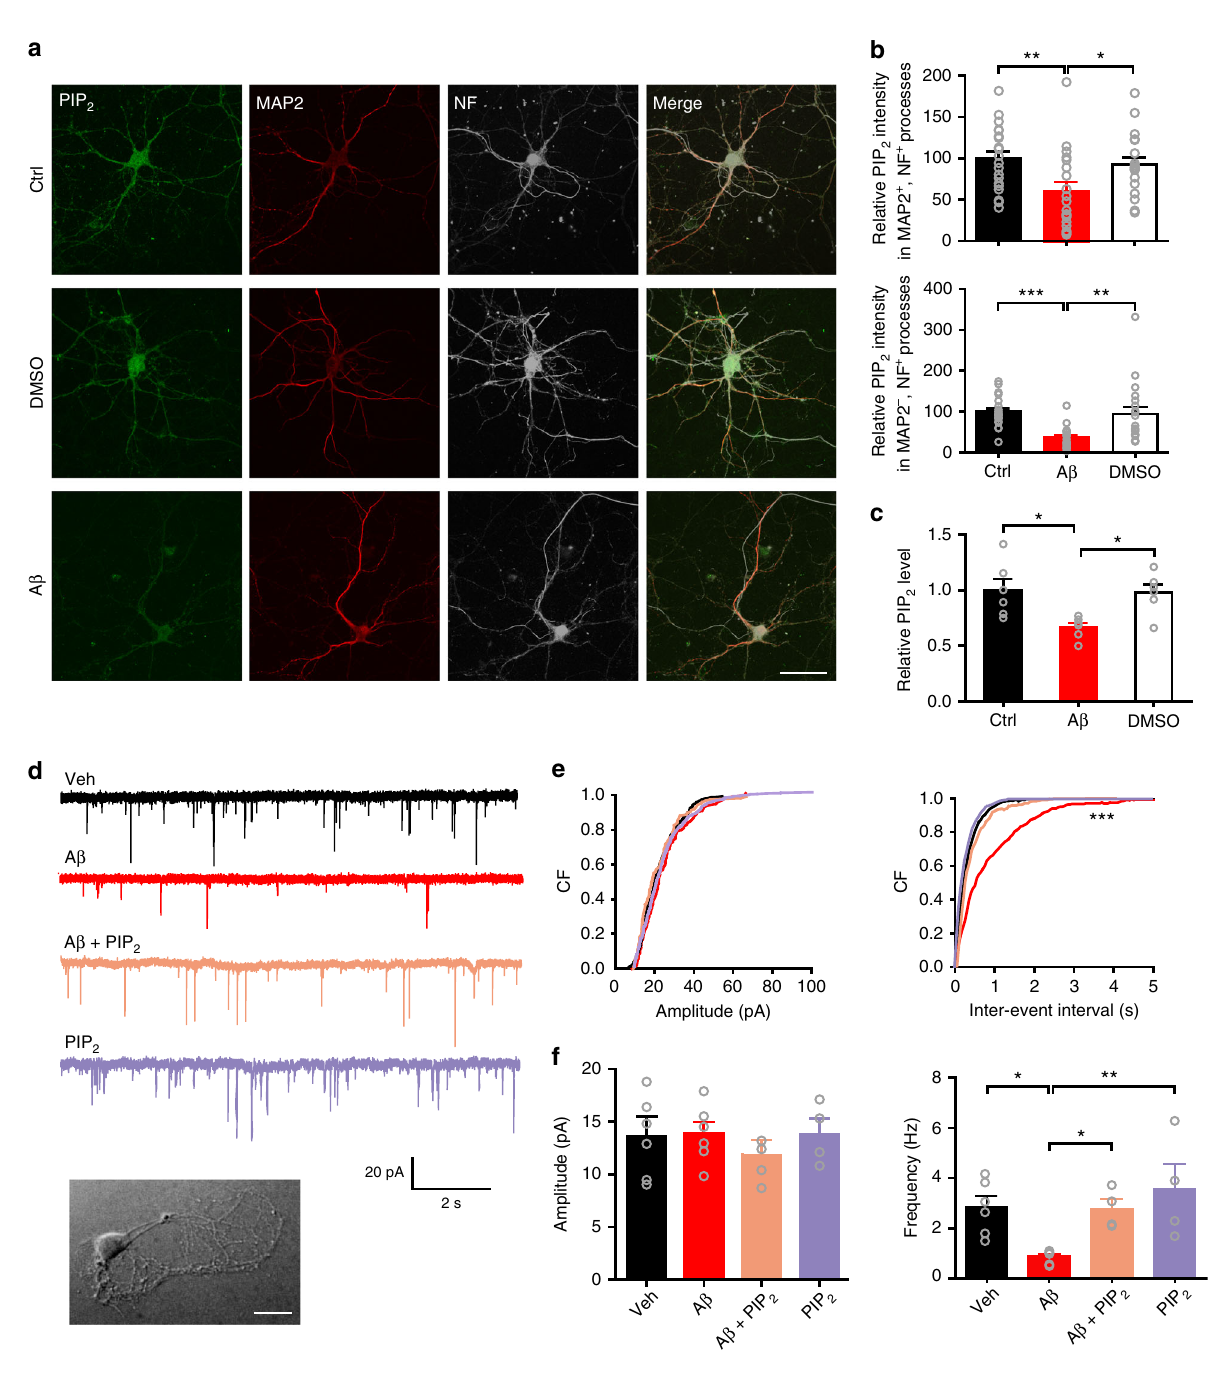
Fig. 4 Reduced axonal PIP 2 accounts for oligomeric A β -induced suppression of presynaptic release probability at the SC-CA1 synapse. a Confocal images of primary hippocampal neurons showing colocalization of PIP 2 , MAP2, and neuro fi lament (NF) along neuronal processes in control, DMSO- treated, and oligomeric A β -treated hippocampal neurons. Bar, 50 μ m. b Histograms showing oligomeric A β suppresses PIP 2 levels signi fi cantly in both dendrites (MAP2 + , NF + , upper panel) and axons (MAP2 − , NF + , bottom panel). One-way ANOVA with post hoc Dunnett ’ s test; F (2,55) = 4.95 (upper); F = 9.39 (bottom); * P < 0.05; ** P < 0.01; *** P < 0.001; N = 19 – 20 per group. c Quanti fi cation of PIP (2,55) 2 levels measured with ELISA showing oligomeric A β suppresses PIP 2 in cultured hippocampal neurons. One-way ANOVA with post hoc Dunnett ’ s test; F (2,15) = 5.87; * P < 0.05; N = 6 per group. d Representative traces of mEACs recorded from isolated hippocampal neurons (an example shown in inset at bottom) in vehicle-treated medium (Veh), oligomeric A β -supplemented medium (A β ), oligomeric A β -supplemented medium with intracellular application of PIP 2 (A β + PIP 2 ), or vehicle- treated medium with intracellular application of PIP 2 (PIP 2 ). Bar, 50 μ m. e , f Cumulative plots ( e ) and mean values ( f ) of mEAC amplitude (left) and frequency (right) in isolated hippocampal neurons in various conditions. Kolmogorov-Smirnov test in e ; one-way ANOVA with post hoc Dunnett ’ s test in f , F (3,16) = 0.54 (amplitude); F (3,16) = 5.47 (frequency); * P < 0.05; ** P < 0.01; *** P < 0.001; N = 4 – 6 per group. Data are mean ± SEM. Source data are provided as a Source Data fi